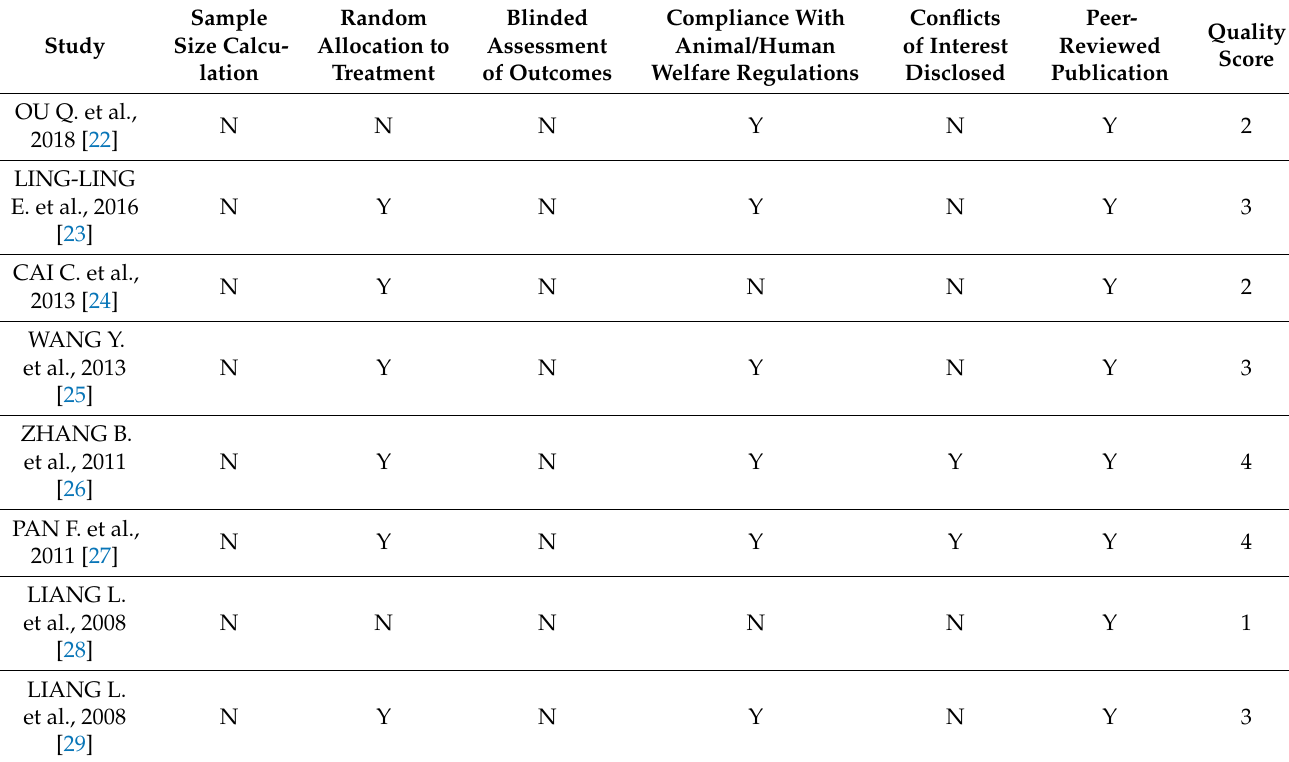
Table 2. Risk of bias